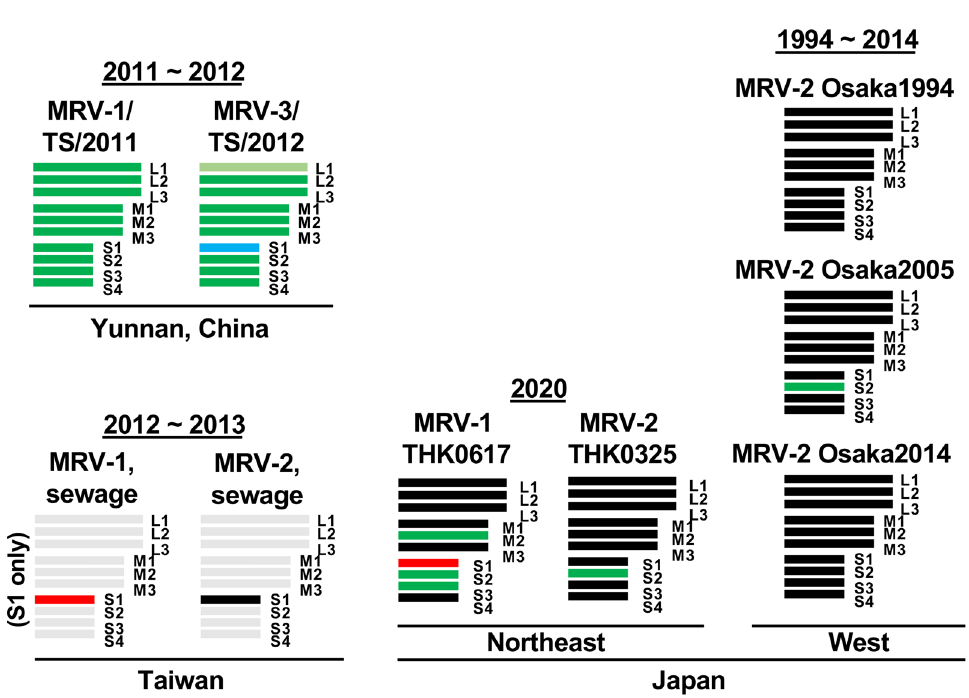
Figure 5. Schematic summary of the genomic compositions of novel MRV isolates and related strains. Based on the nucleotide identity and phylogenetic analysis, segments with close relation were distinguished by colour. Segments of THK0325 and THK0617 showing high nucleotide identity (more than 90% in Fig. 4) with Osaka1994 are in black. In Taiwan strains, S1 of MRV-1 and MRV-2 were closely related to THK0617 (red) and THK0325 (black), respectively (Fig. 2). S2 segments of Osaka2005 and THK0325, and M2, S2, and S3 segments of the THK0617 were related to MRV-1/TS/2011 and MRV-3/TS/2012 (green) (Fig. 3). The sole MRV-3 S1 segment is in light blue, and the unidentified segments of the Taiwan strain are in